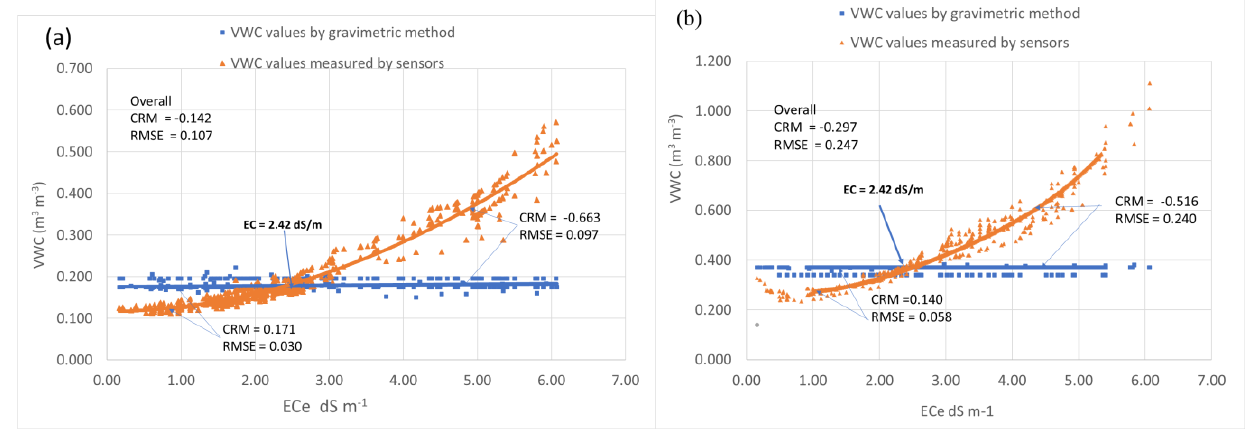
Figure 3. Correlation between actual VWC by gravimetric method and the sensor at three levels of ( a ) salinity concentration and ( b ) temperature.